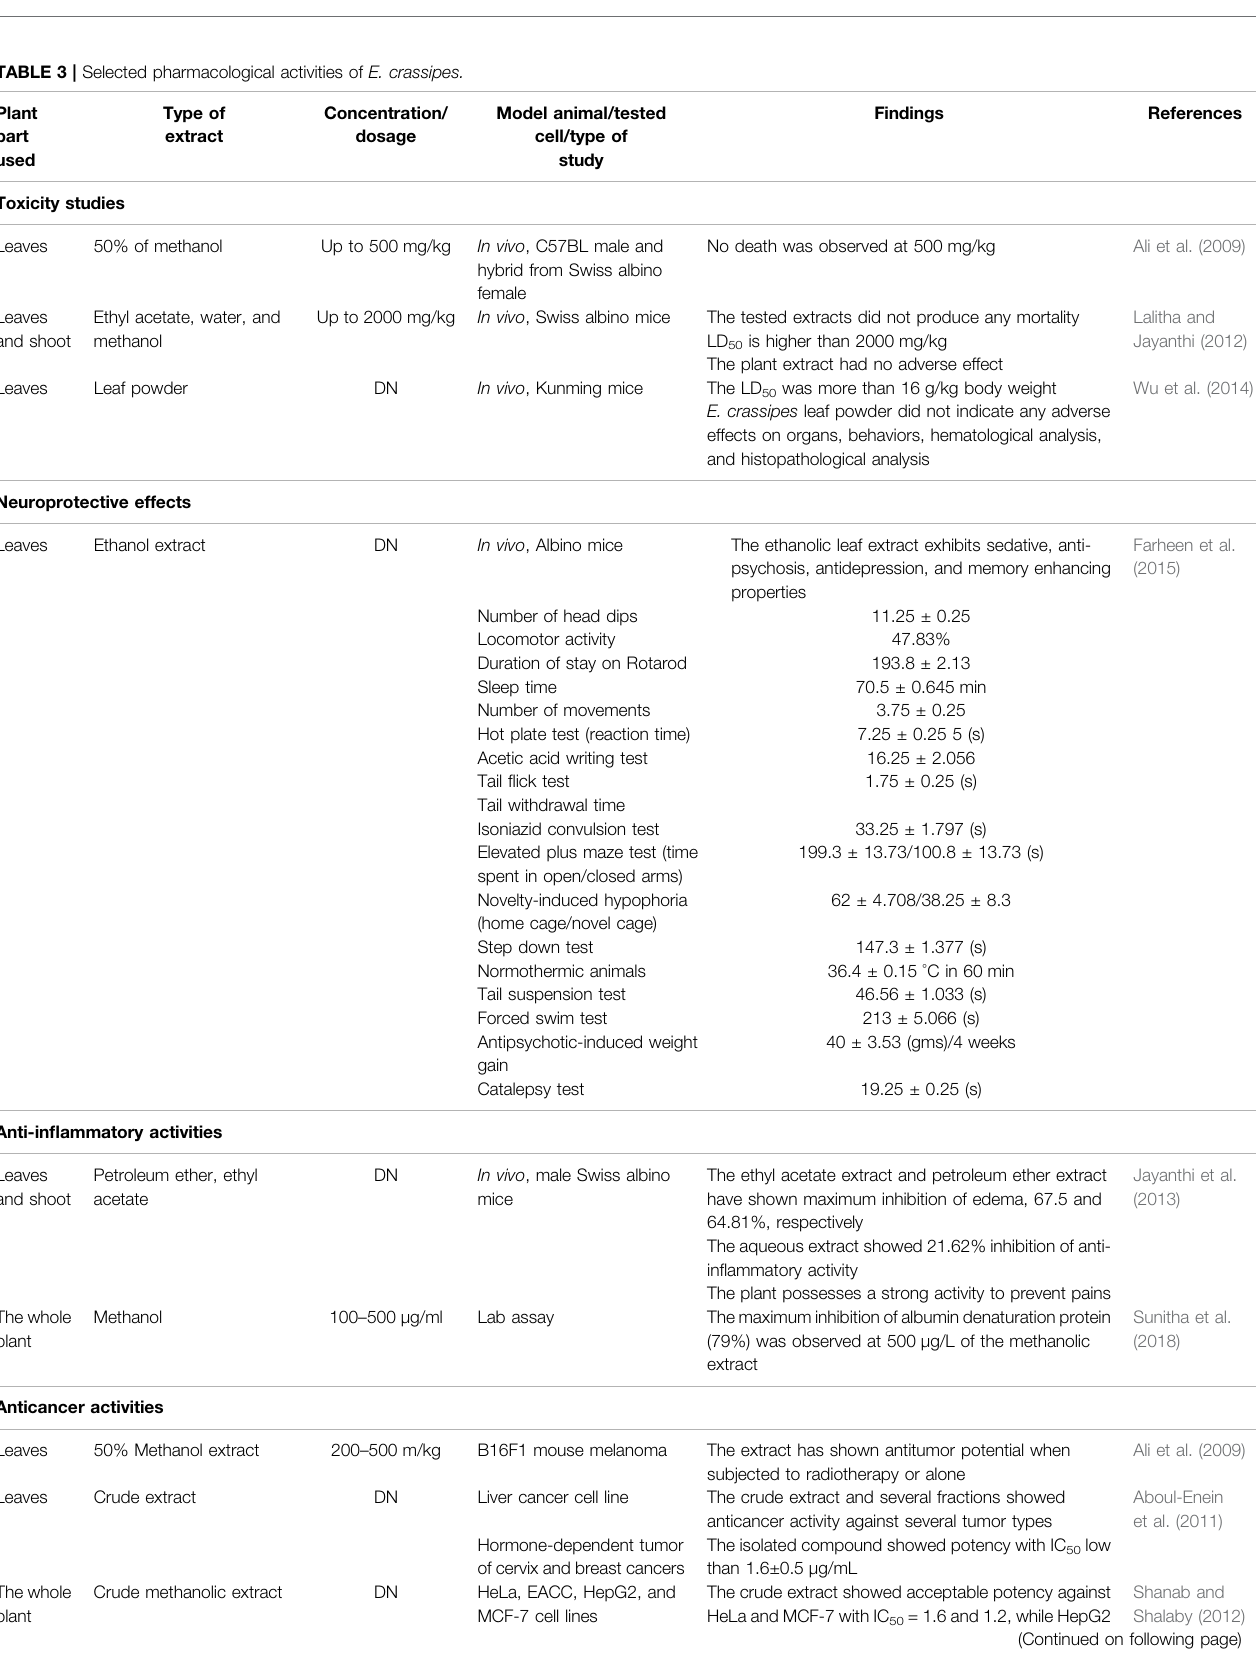
TABLE 3 | Selected pharmacological activities of E.